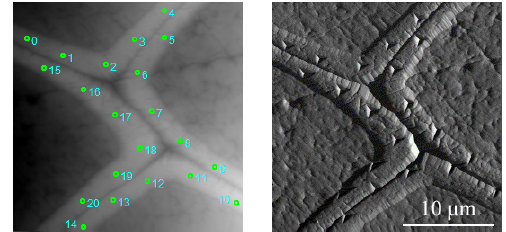
Figure 2. Surface scan (25 × 25 µm) of earlywood before (left) and after (right) nanoindentation.